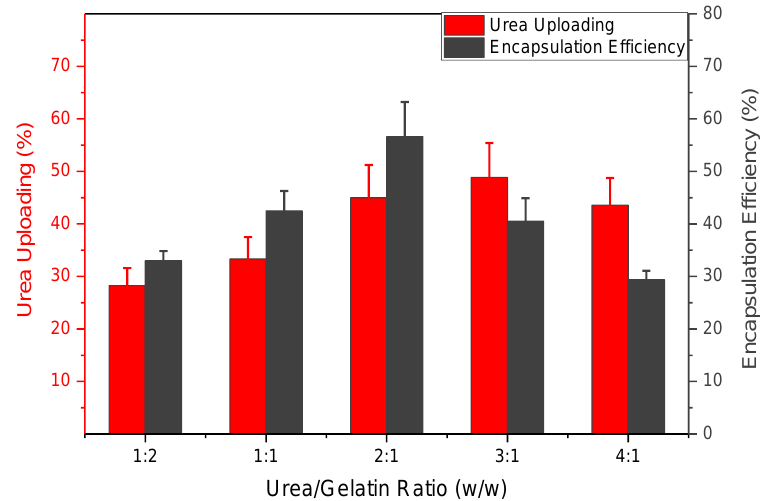
Figure 2. Effect of increasing the urea/gelatin ratio on the effectiveness of urea uploading and en- capsulation in U/G film. U/G film was prepared with a 2 mL g −1 glutaraldehyde concentration and an hour-long reaction period. All values in the figure are represented as mean ± standard deviation.